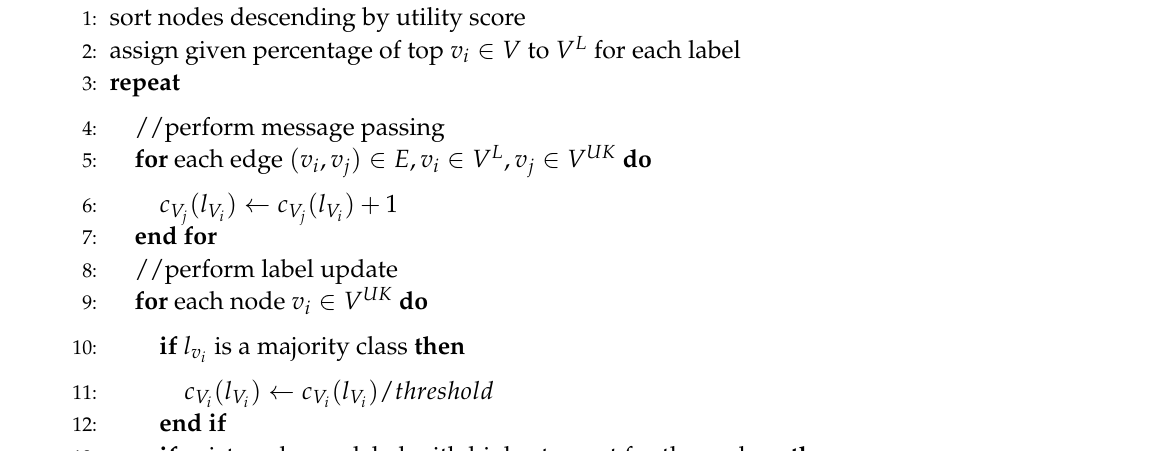
Algorithm 1 Collective Classification